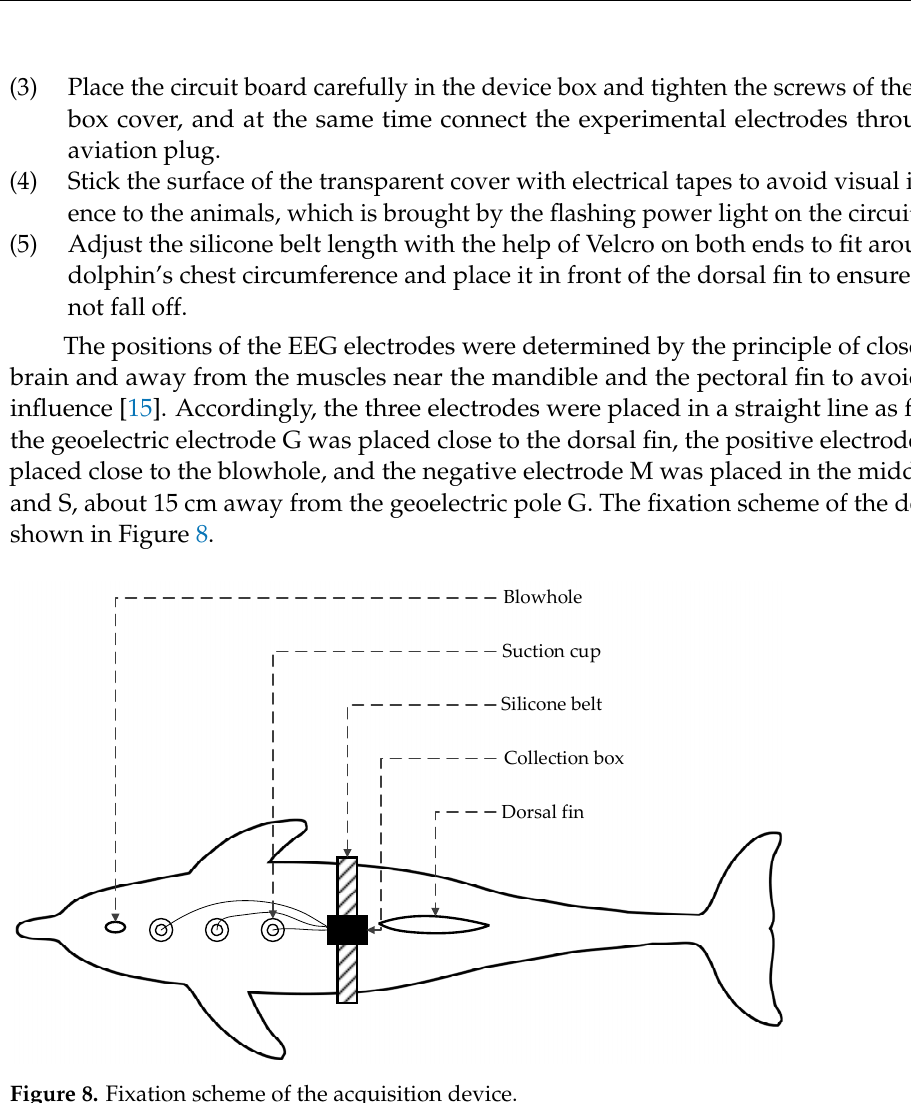
Figure 8. Fixation scheme of the acquisition device.